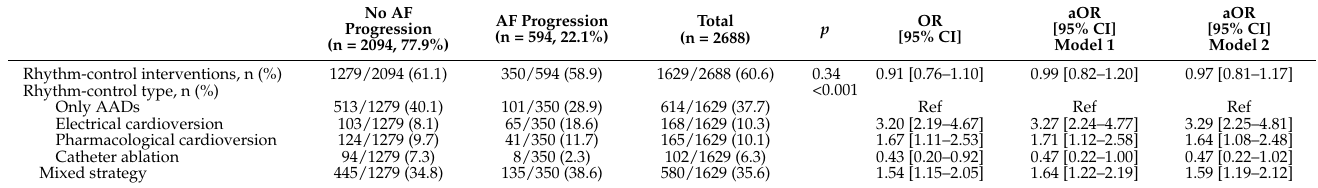
Table 3. Rhythm-control interventions at baseline and association with AF progression at 1 year.